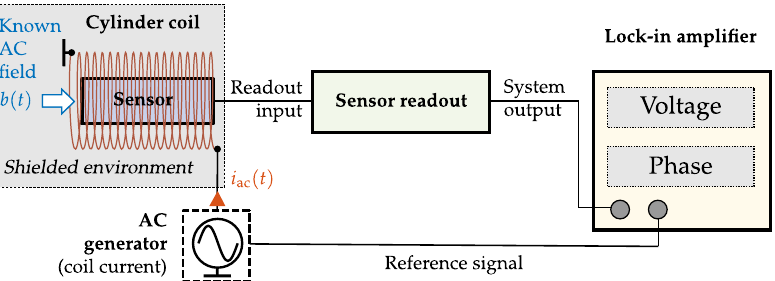
Figure 6. Frequency response measurement of a sensor system in a magnetically shielded environ- ment by lock-in-amplifier, current source and cylinder